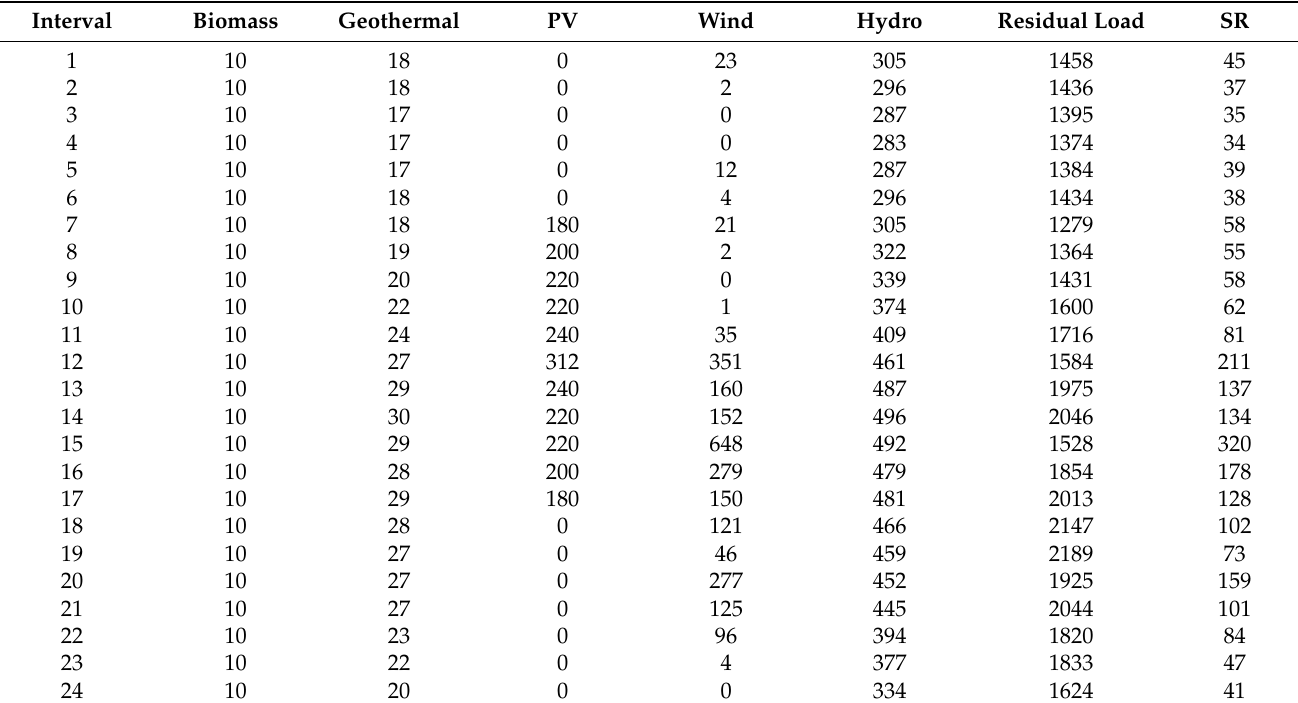
The sharp changes in the net load observed during periods with a high RES contribution require rapid-response generators to get online and follow the curve with minimum deviations. Apart from the increased ramping capability, these generators are usually expensive to start up, and in power systems with frequent renewable intermittency (e.g., due to unexpected cloud occurrences or steep wind gusts or falls), they may start up/shut down multiple times a day. On the contrary, the fuels used by rapid